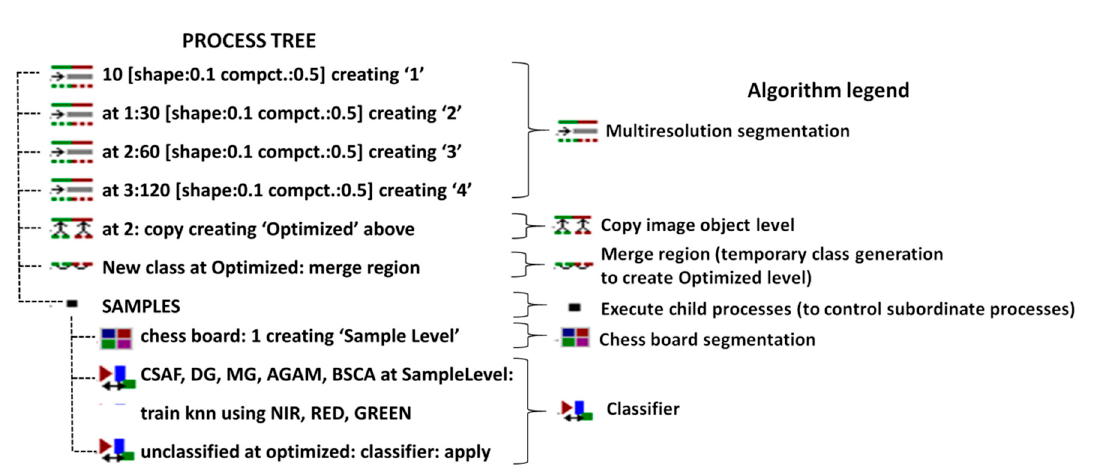
Figure 4. The eCognition process tree used for the segmentation and object classification steps.